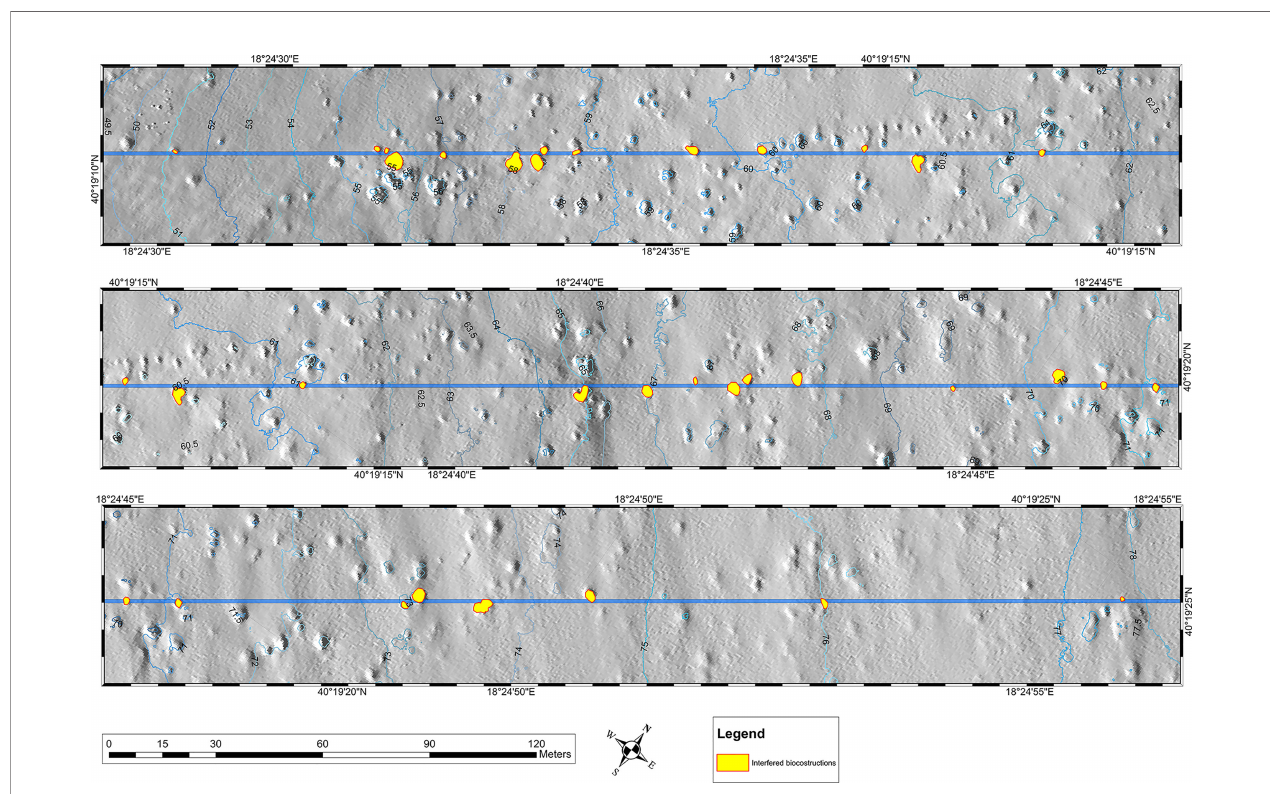
FIGURE 4 | Maps of the 30 interfered outcrops (highlighted in yellow) distributed along the TAP pipeline route, from shallower to deeper